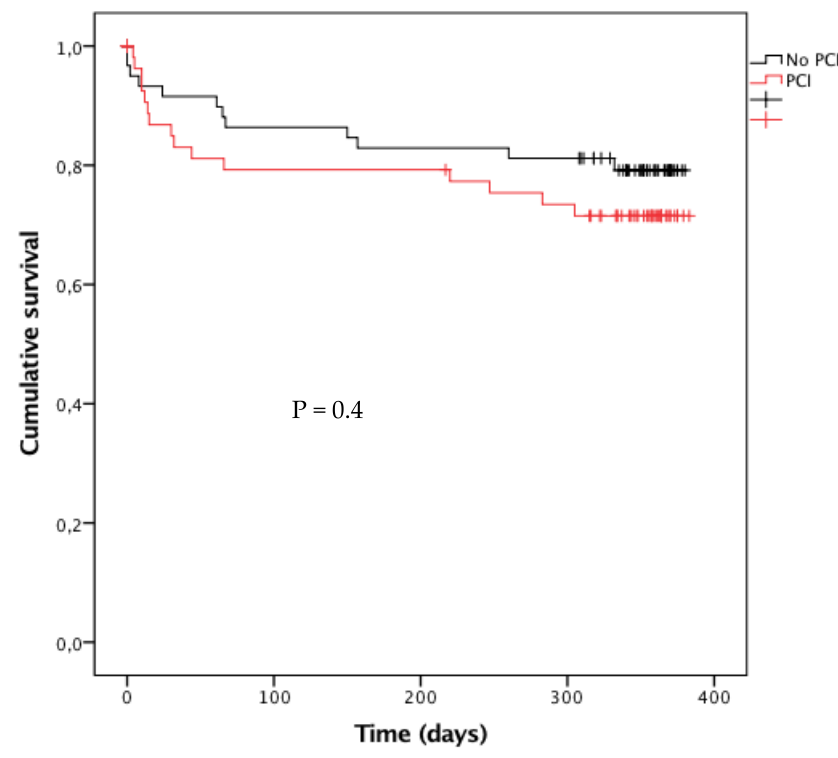
Figure 2. Kaplan–Meier curve of one-year mortality in propensity score-matched population according Figure 2. Kaplan – Meier curve of one-year mortality in propensity score-matched population to percutaneous coronary intervention (PCI) according to percutaneous coronary intervention (PCI) status.